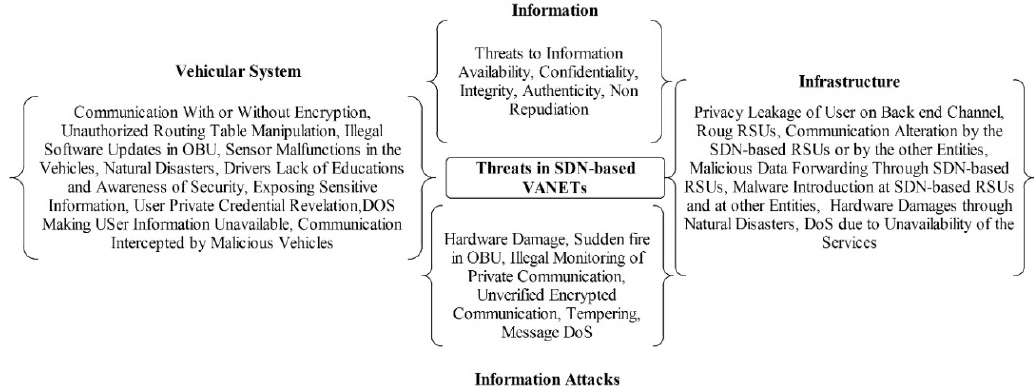
Figure 11. Threats taxonomy in SDN-based vehicular ad-hoc networks (VANETs) with respect to vehicular system, information, and infrastructure.